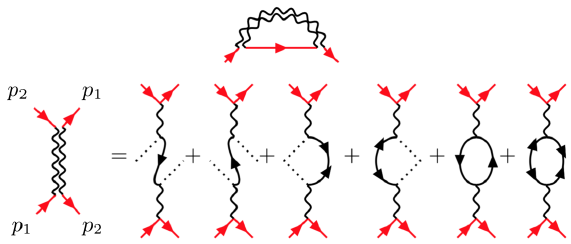
FIG. 1. Second-order self-energy for the Bose polaron as an exchange diagram, where the double wavy line is the second- order induced interaction mediated by the BEC. Solid red lines correspond to the bare Green ’ s function for the impurities, solid black lines are the normal and anomalous Bogoliubov Green ’ s functions for the bosons, dashed lines correspond to condensate particles, and wavy lines represent the zero-energy boson- impurity vacuum scattering matrix T